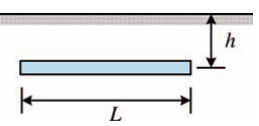
Figure 8. A typical horizontal electrode as a grounding grid.